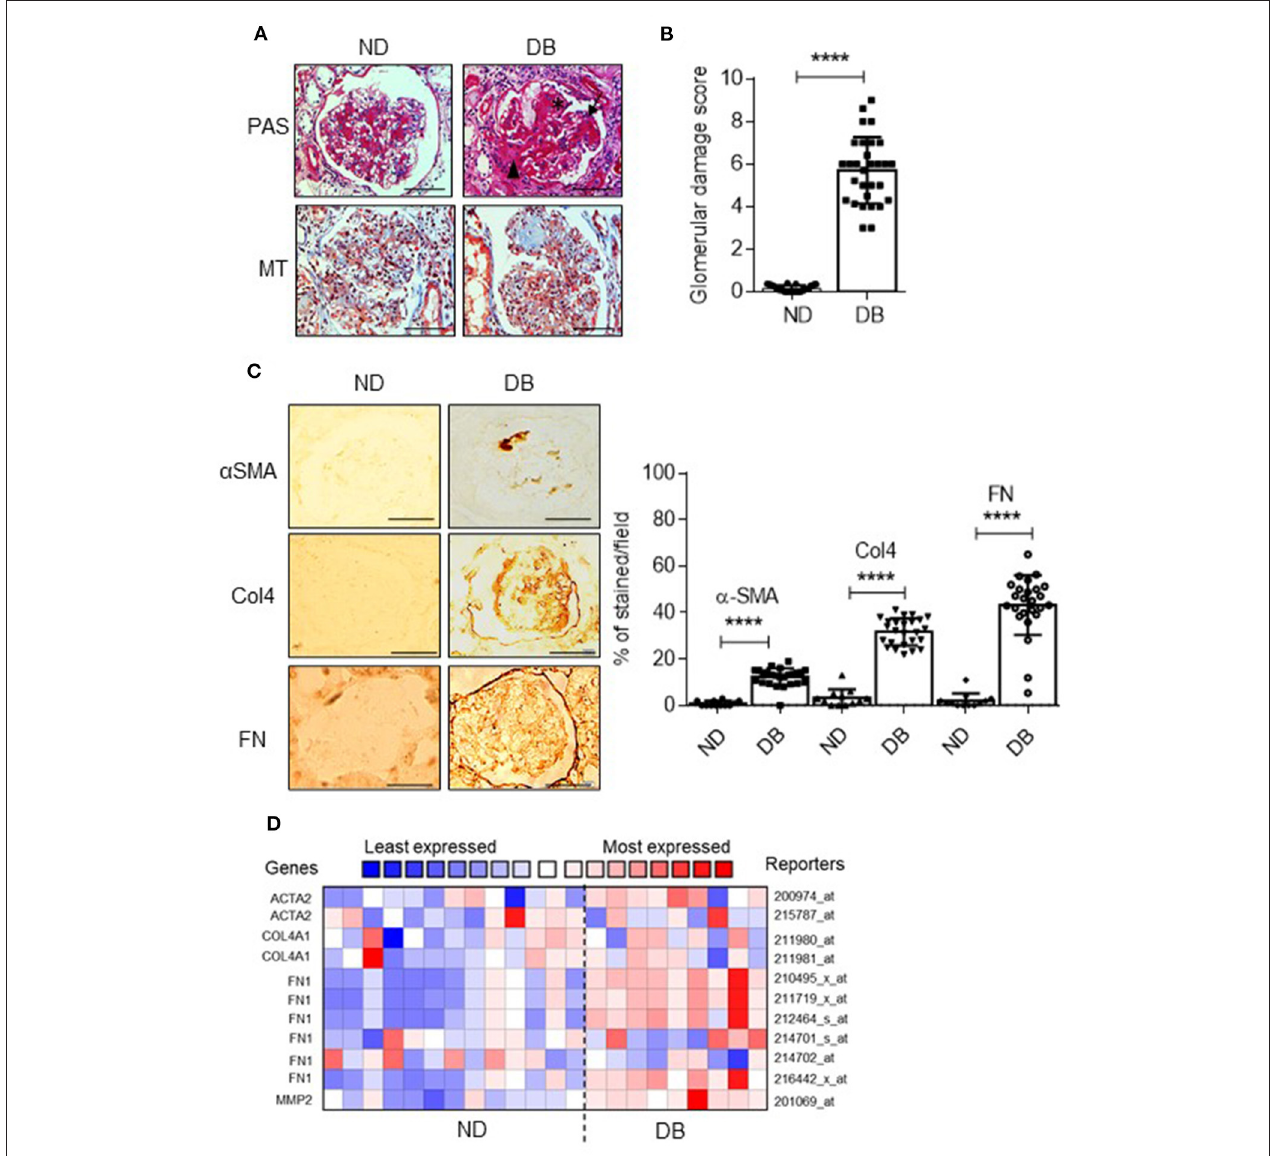
FIGURE 4 | (A) Representative images of Periodic acid-Schiff (PAS) and Masson’s trichrome (MT) staining in glomeruli from ND and DB patients. Magnification = (x 630). Scale bar = 20 µ m. (B) Glomerular damage score was derived from PAS-stained images by summing the glomerular capillary blockage (black asterisk), adhesion of glomerular tuft to Bowman’s capsule (black arrowhead), and focal segmentation of glomerular tuft (black arrow). Each data point represents the average value of 6 glomeruli from n = 30 kidney biopsy samples from ND and DB groups. **** p < 0.0001. (C) Representative images of immunohistochemical analysis for Collagen 4, (Col4), α -smooth muscle actin ( α -SMA), and fibronectin (FN) in glomerular sections from ND and DB biopsies. Magnification (x 400). Scale bar = 50 µ m. The percentage of stained area per field from glomerulus was quantified and represented as a dot plot (right panel). Each data point represents the average value of 6 glomeruli from n = 25 kidney biopsy samples in ND and DB groups. **** P < 0.0001. The intensity of glomerular expression of each marker was quantified using ImageJ. (D) Nephroseq analysis comparing ACTA2( α -SMA), COL4A1, FN1, and MMP2 expression in ND ( n = 13) vs. DB individuals ( n = 9). Nephroseq data is acquired from Woroniecka diabetic glomerulus